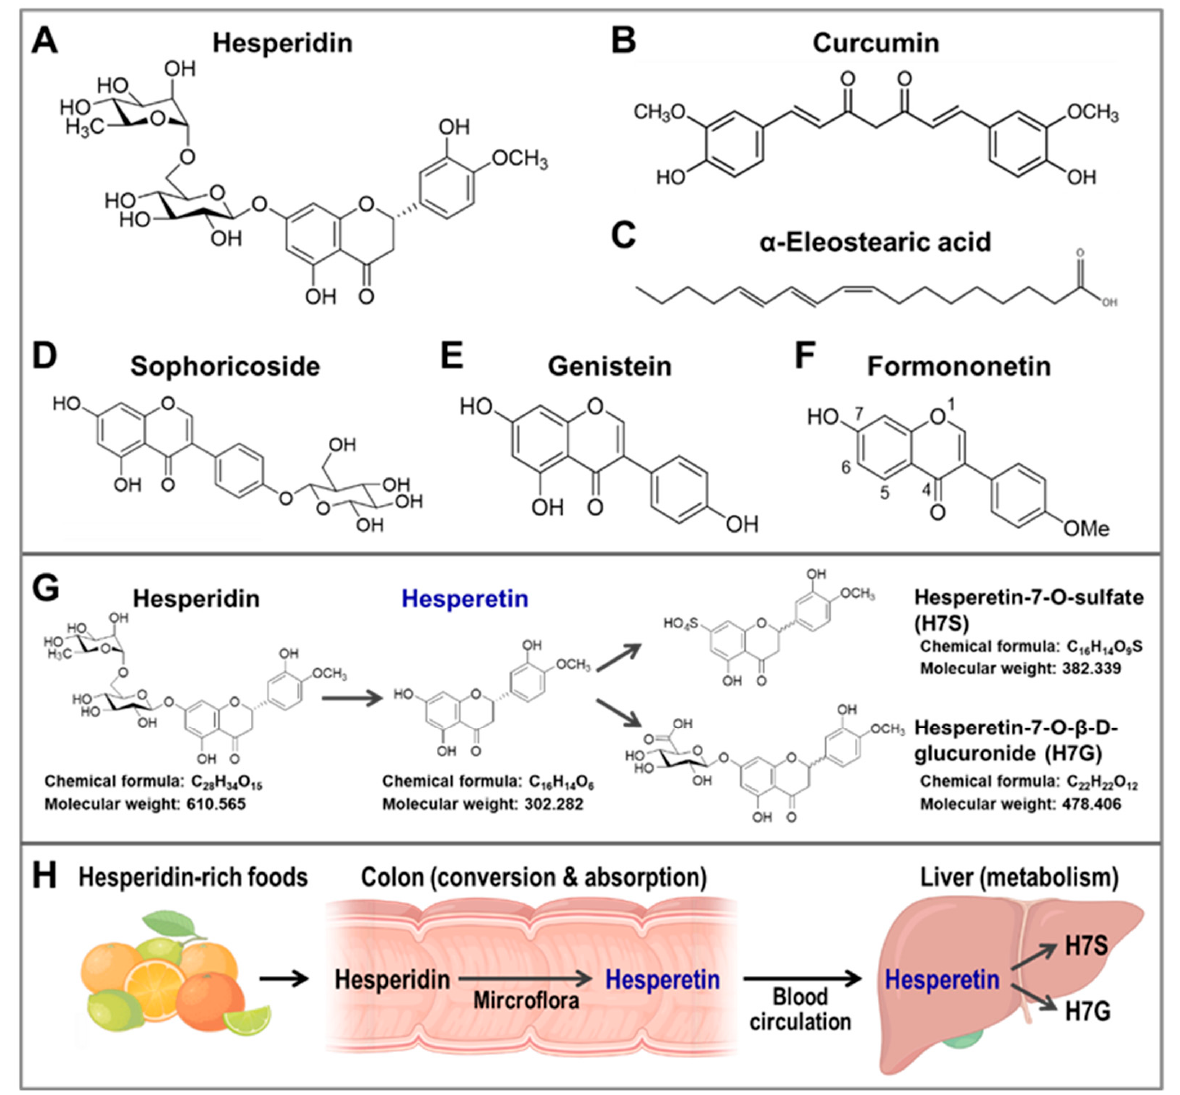
Figure 2. The chemical structures of the plant bio-activators of CISD2. The metabolism and bioavail- ability of hesperidin and its occurrence in foods. ( A – F ) The chemical structures of ( A ) hesperidin, ( B ) curcumin, ( C ) α -eleostearic acid, ( D ) sophoricoside, ( E ) genistein, ( F ) formononetin. ( G ) The chemical structures and metabolic processing of hesperidin and its derivatives in vivo. ( H ) Hesperidin, a bioflavonoid compound, is mostly found in citrus fruits, including oranges, grapefruits, tangerines, and lemons. In the colon, hesperidin is converted into hesperetin by the microflora, and then hesperetin can be absorbed into systematic circulation by colonocytes. In the liver, hesperetin can be conjugated with a glucuronide or sulfate, which results in two other major metabolites, namely hesperetin-7-O-sulfate (H7S) and hesperetin-7-O- β -D-glucuronide (H7G), respectively. The figure was created with